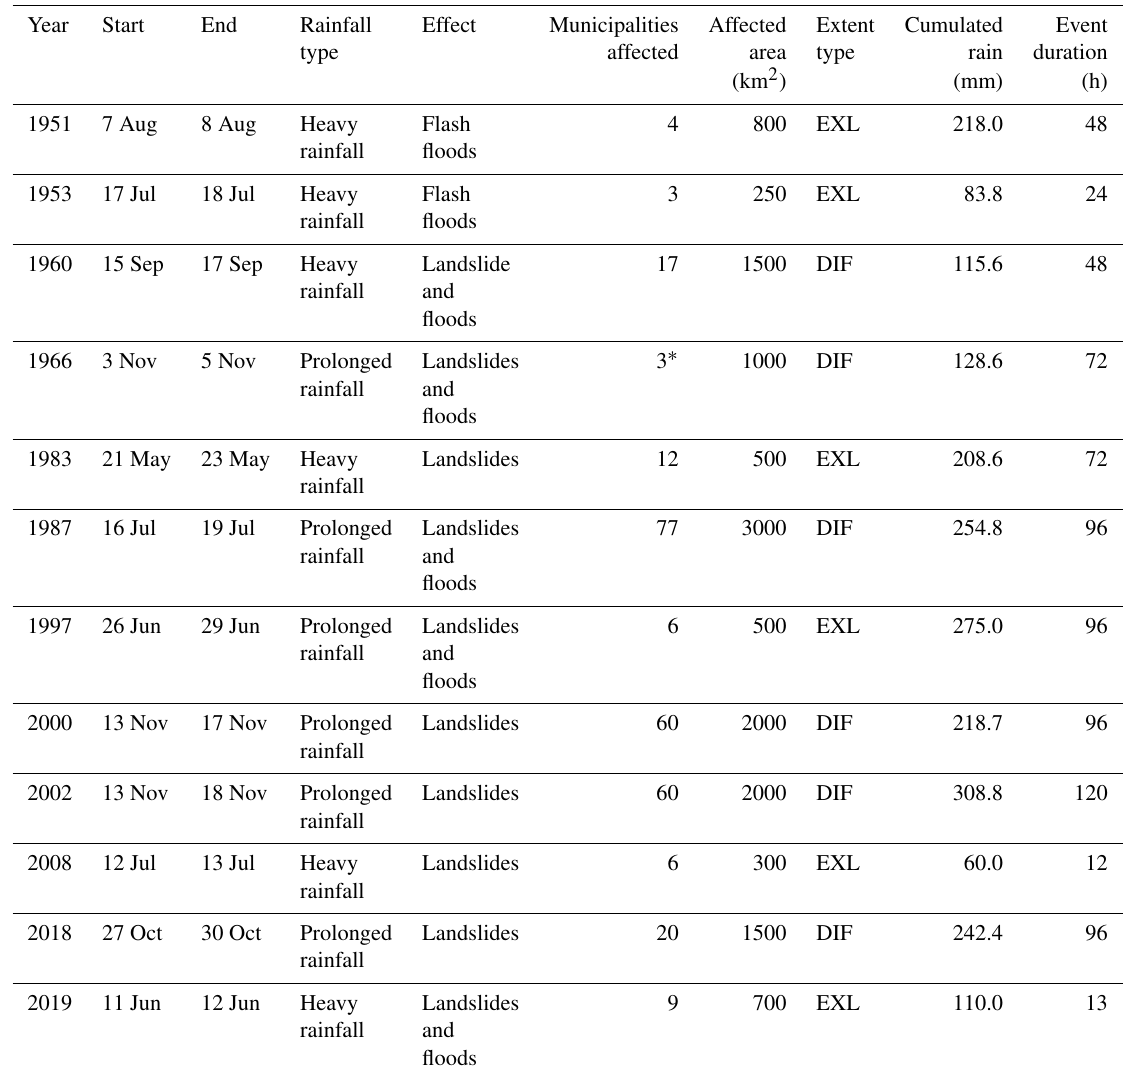
Table 1. Geo-hydrological events recorded from 1951 up to 2019 considered for the back-analysis study. In the table the event classification is also reported considering the events’ spatial extent: the extreme localized events (EXLs) and the more diffuse ones (DIFs). ∗ indicates uncertain data.